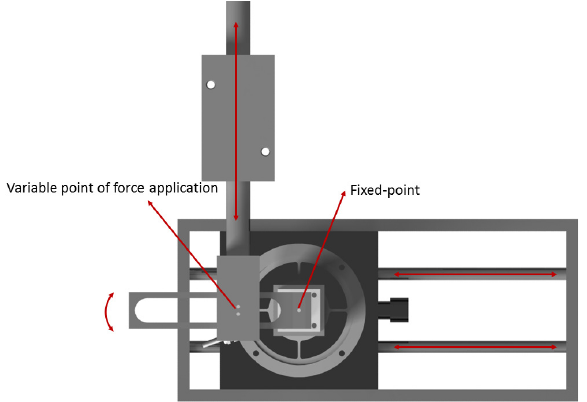
Figure 4. Lever arm mechanism implementation.